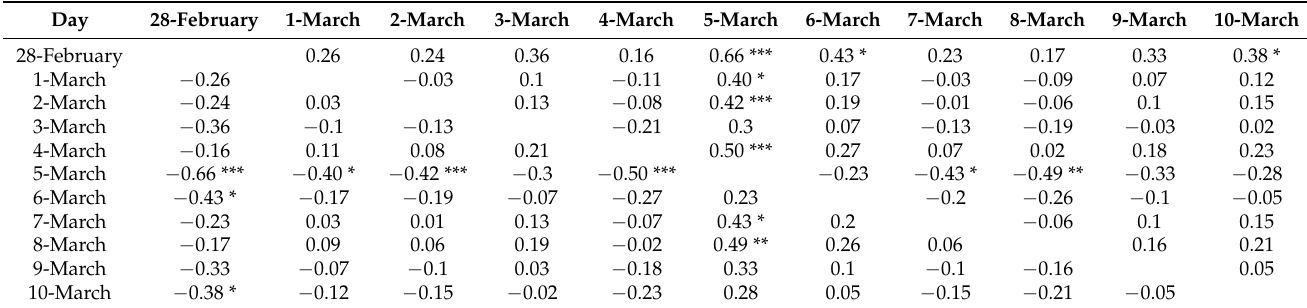
Table 4. Post hoc test for all pairwise comparisons of LMF-HRV-correlation mean between days for the California’s group (* p < 0.05, ** p < 0.01, *** p < 0.001).